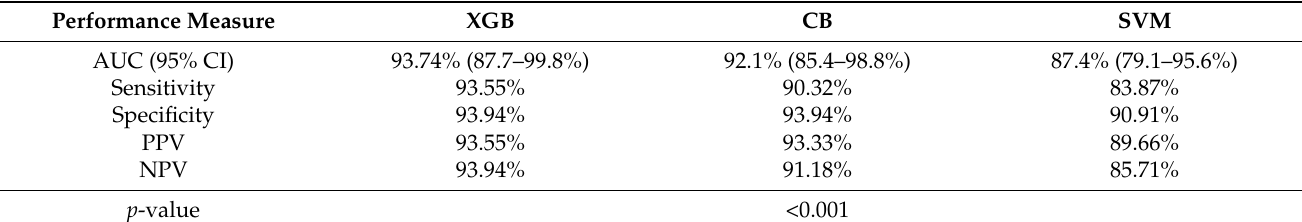
Figure 4. Receiver operating characteristic (ROC) curves of machine learning models. XGboost ( A ), CatBoost ( B ) and support vector machine (SVM) ( C ). Light blue areas represent the respective 95% confidence intervals calculated with bootstrapping. AUC: Area Under the Curve.